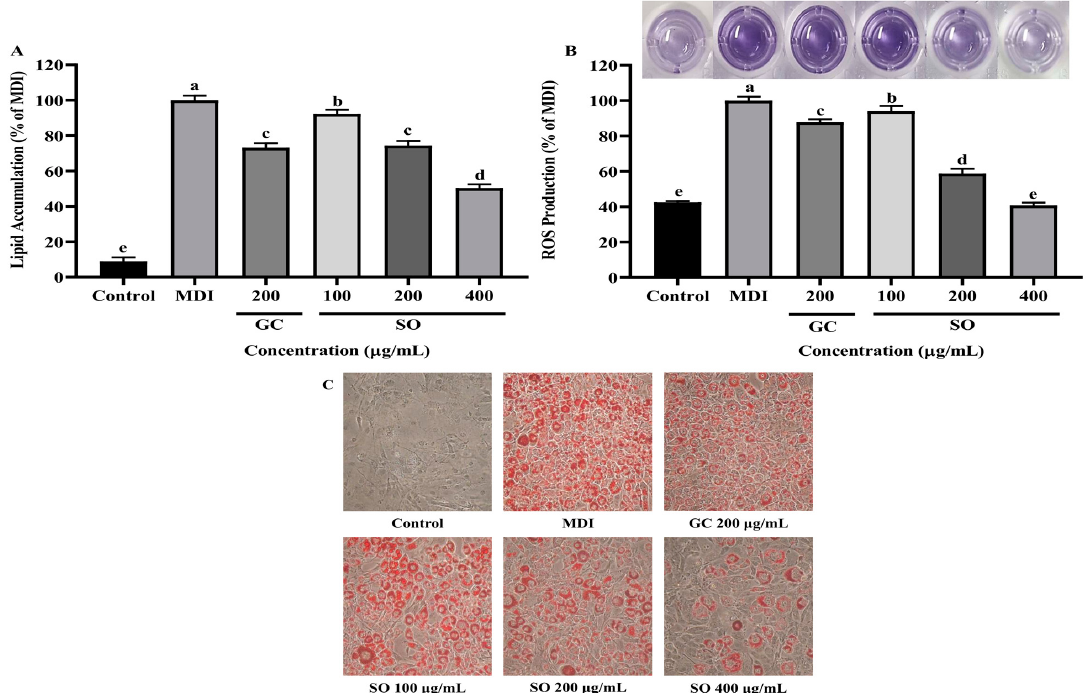
Figure 2. Effect of SO on cell viability of 3T3-L1 preadipocytes ( A ) and adipocytes ( B ). Values are expressed as mean ± SD of experiments ( n = 3). Different alphabets indicate significant differences at the level of p < 0.05. 3.3. SO Reduces Lipid Accumulation and ROS Production in 3T3-L1 Adipocytes SO dose-dependently reduced lipid accumulation in 3T3-L1 adipocytes starting from 100 µ g/mL (Figure 3A,C). SO showed a similar lipid accumulation inhibition rate to GC at 200 µ g/mL and up to 50% lipid accumulation inhibition rate at 400 µ g/mL. SO also dose- dependently reduced ROS production in 3T3-L1 adipocytes (Figure 3B). The inhibitory effect of SO on ROS production in 3T3-L1 adipocytes was higher than that of GC at the same concentration (200 µ g/mL).